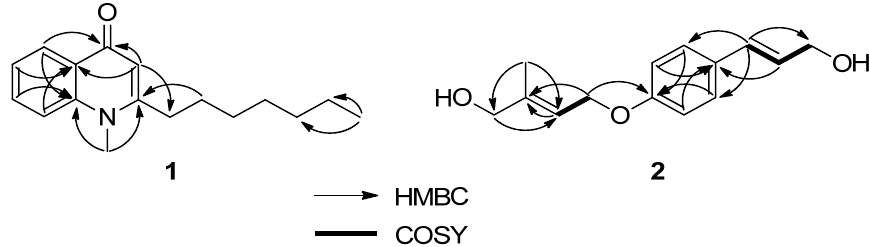
Figure 4. HMBC and COSY correlations of compounds 1 and 2 from T. ruticarpum.